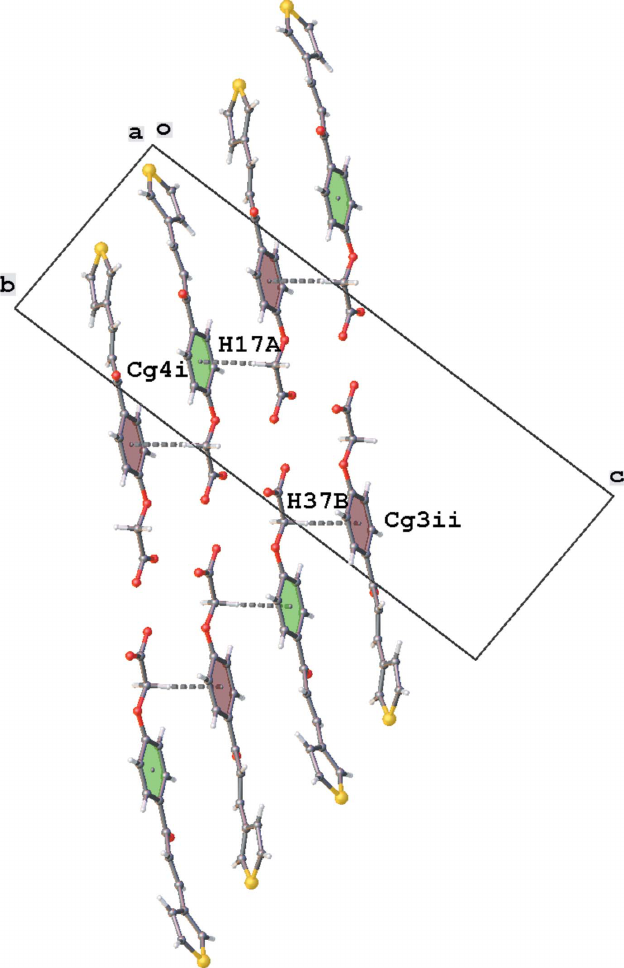
Figure 6 A view down the a axis of the intermolecular C—H (cid:3)(cid:3)(cid:3) (cid:2) interactions of the title compound. Colour codes used: magenta for ring C10–C15, green for ring C30–C35. Cg 3 and Cg 4 are the centroids of the C10–C15 and C30–C35 rings, respectively. K atoms have been omitted.